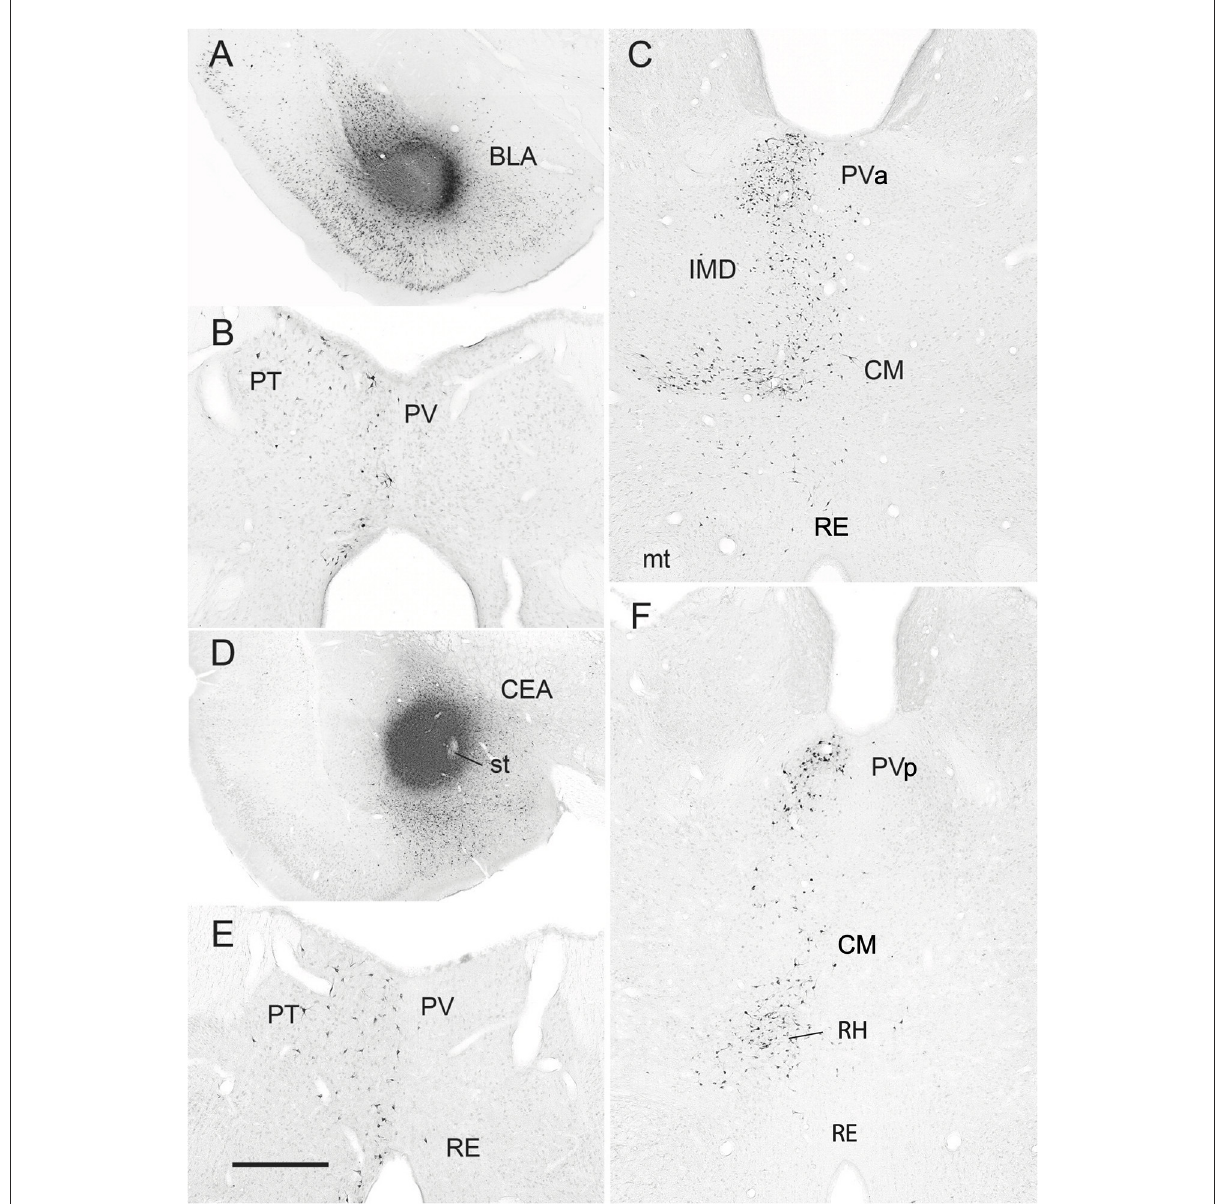
FIGURE7 (A–C) Low-magnification bright-field micrographs of transverse sections through the forebrain depicting the site of a retrograde tracer (FluoroGold) injection in the basolateral nucleus (BLA) of the amygdala of the rat (A) and patterns of retrogradely labeled cells in the anterior paraventricular (PV) and paratenial (PT) nuclei of dorsal midline thalamus (B) and the posterior PV and central medial (CM) nuclei of the rostral intralaminar thalamus (C) produced by this injection. Note the significant numbers of retrogradely labeled neurons in the posterior PV and CM (C) , but fewer in the anterior PV, PT and nucleus reuniens (RE) (B,C) with this injection. (D–F) Low-magnification bright-field micrographs of transverse sections through the forebrain depicting the site of a retrograde tracer injection in the central nucleus (CEA) of the amygdala (D) and patterns of retrogradely labeled cells in the anterior PV, PT and RE nuclei of thalamus (E) and the posterior PV, CM and rhomboid (RH) nuclei of the thalamus (F) produced by this injection. Note moderate numbers of labeled cells in RE (E) , PT (E) , CM (F) and the anterior PV ( E ), but much denser clusters of cells in the posterior PV (F) and RH (F) . IMD, interomediodorsal nucleus of thalamus, mt, mammillothalamic tract; PVa, anterior paraventricular nucleus of thalamus; PVp posterior paraventricular nucleus of thalamus; st, stria terminalis. Scale bar for (A) = 750 µ m; for (B) = 300 µ m; for (C) = 500 µ m; for (D) = 700 µ m; for (E) = 400 µ m; for (F) = 450 µ m. Modified from Vertes and Hoover